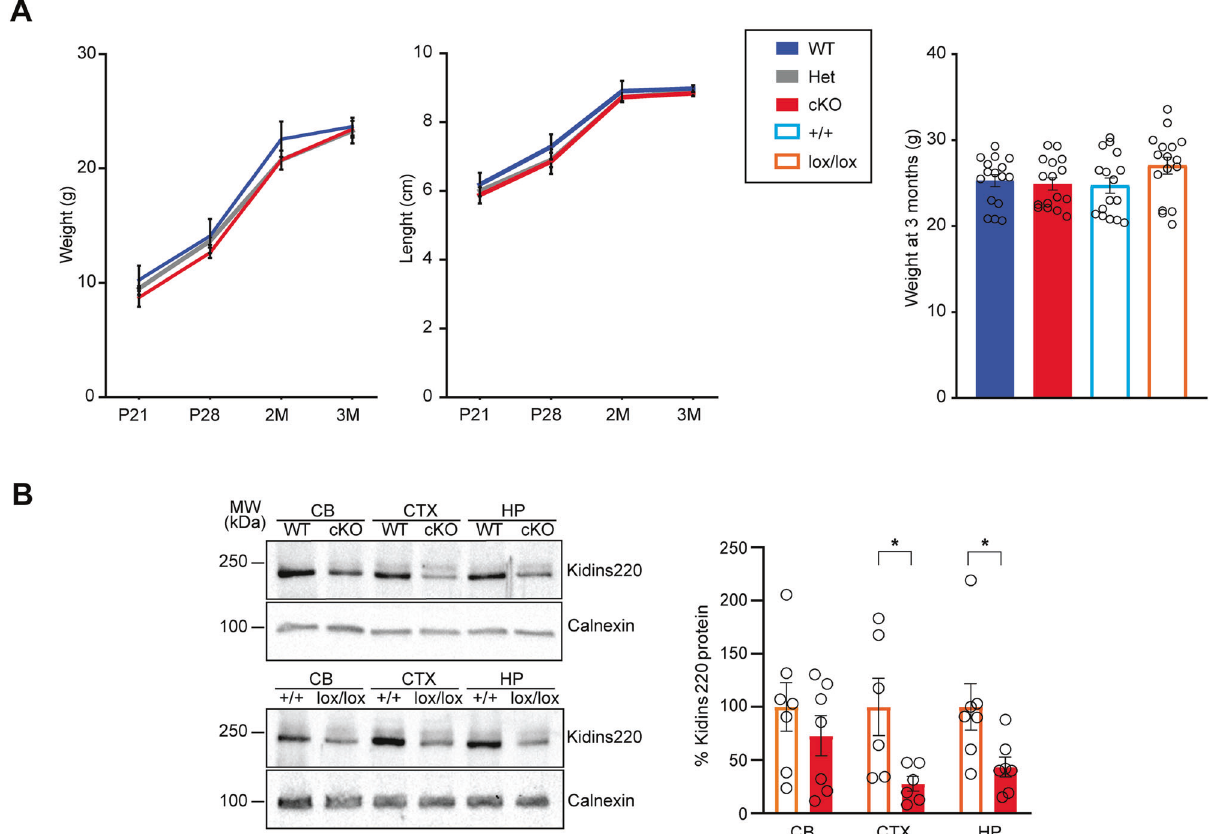
Fig. 1 Generation of animals bearing the CaMKII-driven, forebrain-speci fi c deletion of Kidins220. A Left: Kidins220 lox/lox;Cre/ + (cKO, red), Kidins220 lox/ + ;Cre/ + (Het, gray), and Kidins220 + / + ;Cre/ + (WT, blue) animals display comparable development for weight (left) and length (middle) up to 3M of age ( n : P21: 5 WT, 3 cKO, 14 Het; P28: 4 WT, 3 cKO, 7 Het; 2M: 7 WT, 9 cKO, 7 Het; 3M: 16 WT, 13 cKO, 11 Het). Right: Kidins220 + / + ( + / + , light blue) and Kidins220 lox/lox (lox/lox, orange) animals display comparable weight to WT and cKO at 3M of age. One-way ANOVA ( p > 0.05, n = 16 for all the genotypes). B Animals were killed at 3M and brains dissected into cerebellum (cb), cortex (ctx), and hippocampus (hp), lysed and analysed by western blotting with anti-Kidins220 antibodies and anti-calnexin antibodies as loading control. Left: representative immunoblots for WT and cKO animals (top), + / + and lox/lox animals (bottom) are shown. Right: The comparison of Kidins220 expression levels in lox/lox and cKO brain lysates ran on the same nitrocellulose membrane shows a signi fi cant reduction of Kidins220 protein in the cortex and hippocampus of cKO mice compared to lox/lox, while in the cerebellum expression levels are comparable. Values are plotted as mean ± S.E.M. and individual values are represented with circles. Unpaired Student ’ s t -test, * p < 0.05 ( n : Cerebellum: lox/ lox 7, cKO 7; Cortex: lox/lox 6, cKO 6; Hippocampus: lox/lox 7, cKO